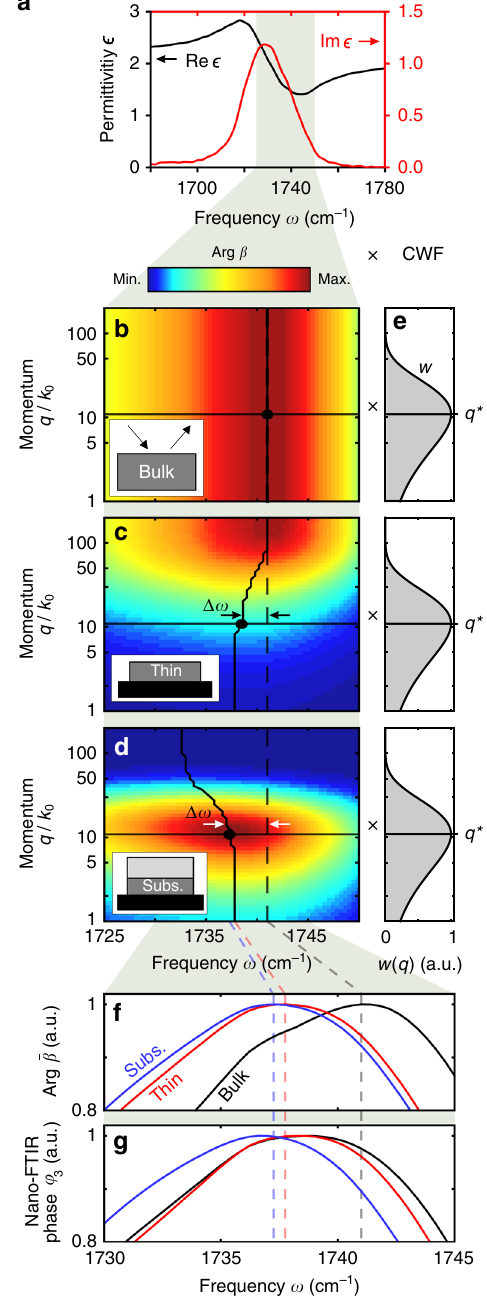
Fig. 5 Geometry- and momentum-dependent spectral shifts in nano-FTIR phase spectra. a Real (black) and imaginary (red) parts of the dielectric function of PMMA, showing a typical Lorentz oscillator shape. Phase of the Fresnel re fl ection coef fi cient, Arg β , for different PMMA samples: b bulk PMMA, c t 1 = 20 nm-thick PMMA layer at the surface of a silicon substrate, d t 2 = 20 nm-thick subsurface PMMA layer at the surface of a silicon substrate and at depth d 2 = 40 nm below PS. The vertical/curved solid lines indicate the frequency where Arg β has its maximum. e Coupling weight function w ( q ) calculated with the tip in contact with sample ( H = 0). Horizontal lines indicate the momentum q * of highest tip-sample coupling. f Phase of near- fi eld re fl ection coef fi cient, Arg (cid:2) β , obtained by multiplying the Fresnel re fl ection coef fi cient (panels b – d ) with the CWF (panel e ), and integration over all momenta q . g Calculated nano-FTIR phase spectra φ 3